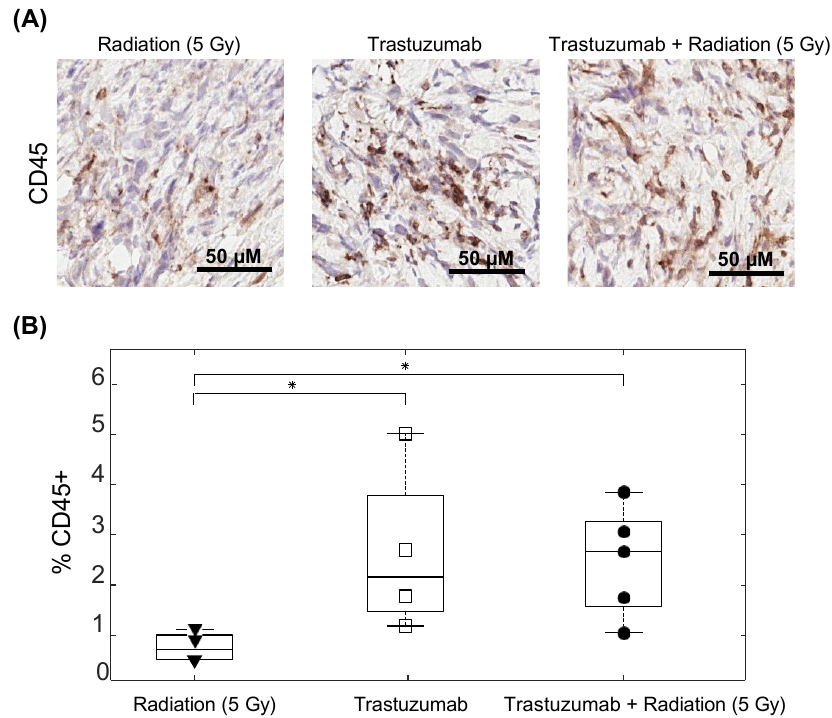
Figure 7. Percent CD45+ in single agent radiation, trastuzumab, and combination-treated tumors on Day 7. All radiation single-agent and combination groups were treated with 5 Gy of radiation on Day 0. All trastuzumab single-agent and combination groups were treated with 10 mg/kg of trastuzumab on Days 0 and 3. ( A ) Representative images of CD45 staining in single-agent and combination treatment groups. ( B ) Percent CD45+ staining from the central slices of tumors in the single-agent and combination treatment groups, revealing significant increases in CD45+ in trastuzumab single-agent and trastuzumab and radiation (5 Gy) treatment compared with radiation alone (* p = 0.03). No significant difference was seen in mice treated with single-agent trastuzumab and trastuzumab and radiation ( p = 1.00).